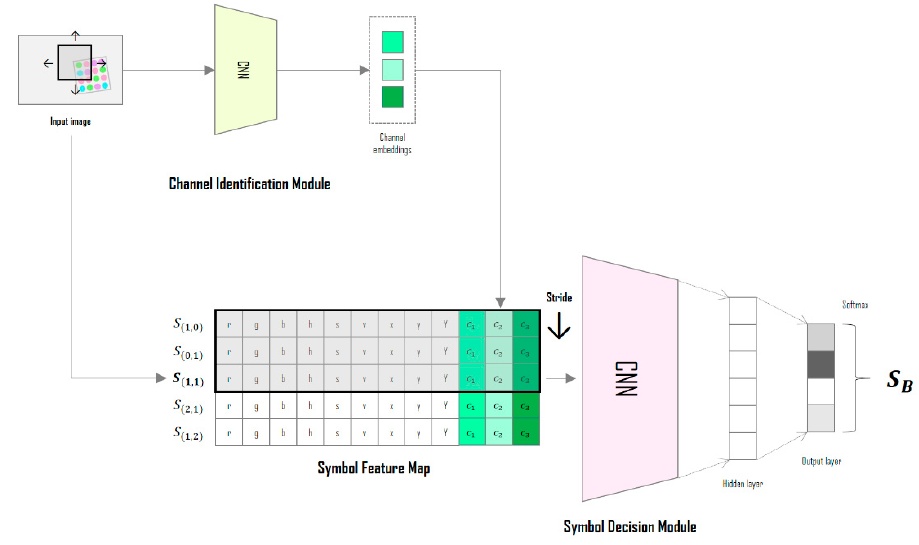
Figure 1. Conceptual diagram of the deep-learning neural network in the proposed method. In the symbol feature map of Figure 1, the bold represents the target symbol (color) to be determined and the different colors mean the different channel identification vectors from CIM.